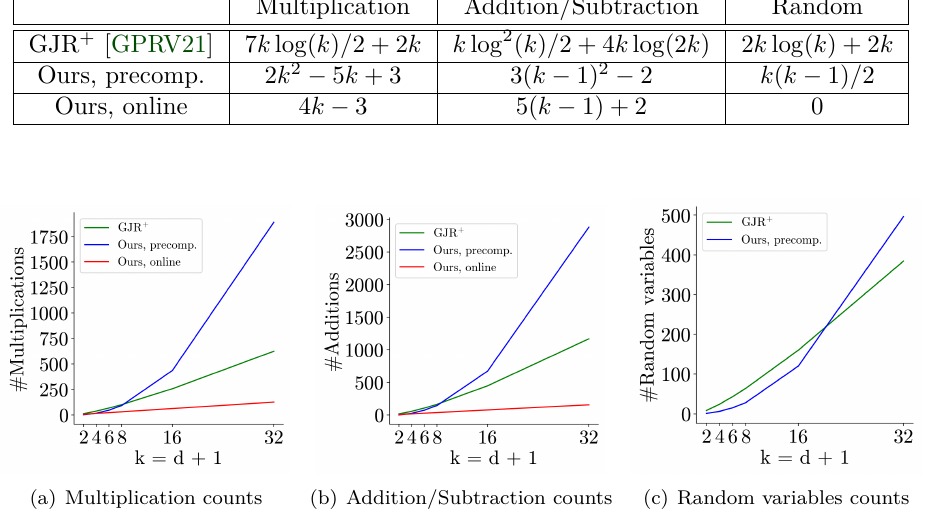
Figure 3: Operations counts for k = { 2 , 4 , 8 , 16 , 32 }